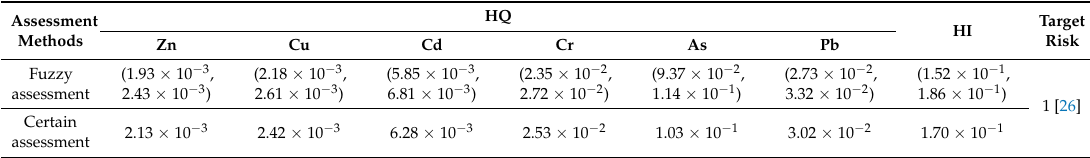
Table 5. Hazard quotient (HQ) and hazard index (HI) of trace elements in surface water from Honghu